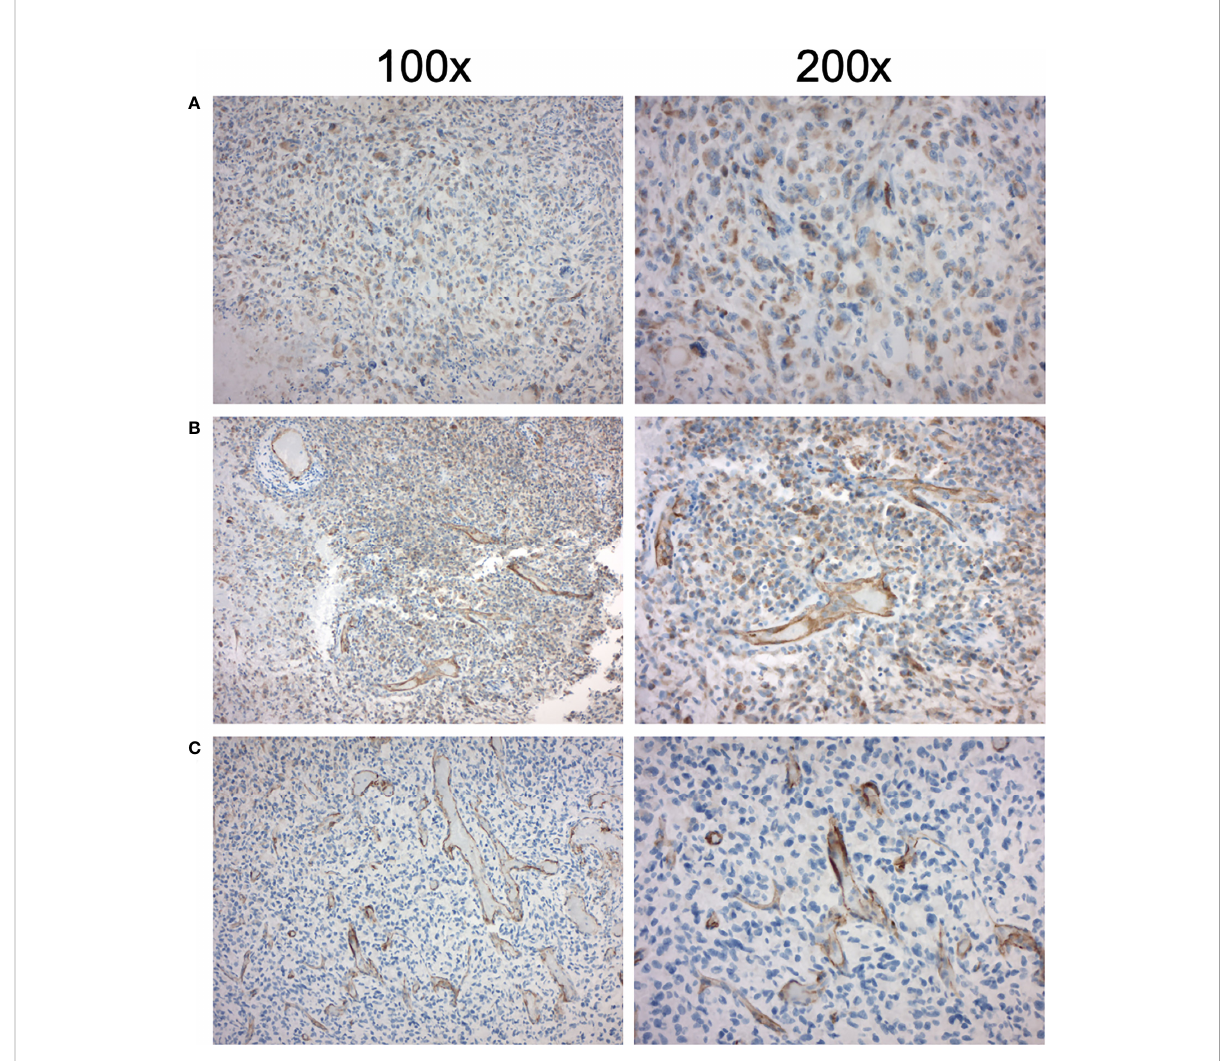
FIGURE 1 Immunohistochemical PSMA expression in high-grade glioma of three patients eligible for [ 177 Lu]Lu-PSMA therapy. Left column 100x magni fi cation, right column 200x magni fi cation. (A) First patient with increased endothelial PSMA expression with H-score 60 and TBR max of 1.03 (B) Second patient with increased endothelial PSMA expression with H-score 65 and TBR max of 1.06 (C) Third patient with increased endothelial PSMA expression with H-score 90 and TBR max of